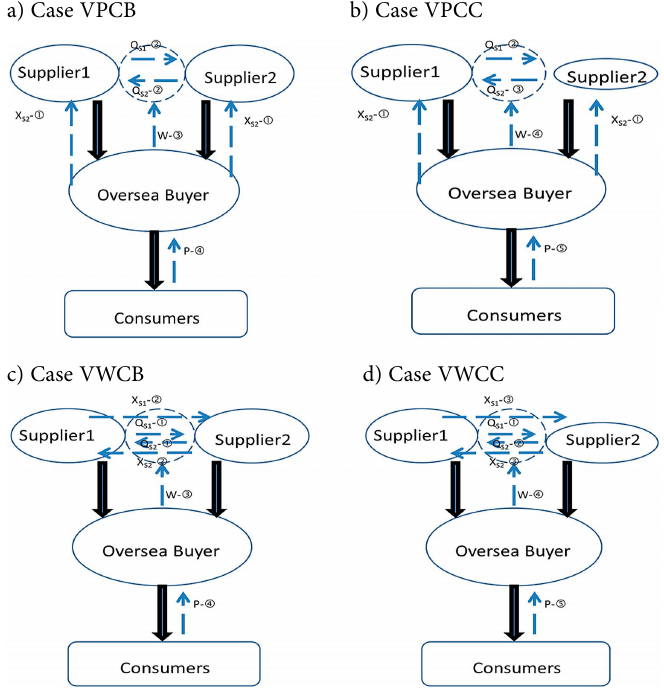
Figure 1. Supplier innovation models (X: innovation; Q: product quantity; W: wholesale price; P: retail price; solid line: product flow; dotted line: